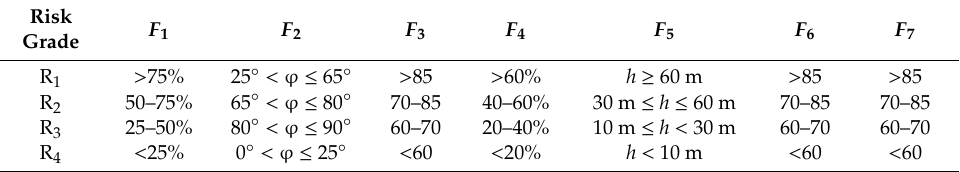
Table 3. Grade criterion of evaluation index for